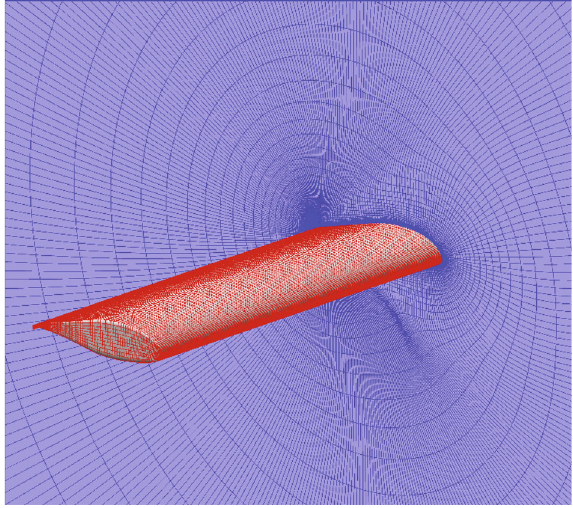
Figure 4: Comparison of pressure distributions of an A821201 in fi nite-straight wing.